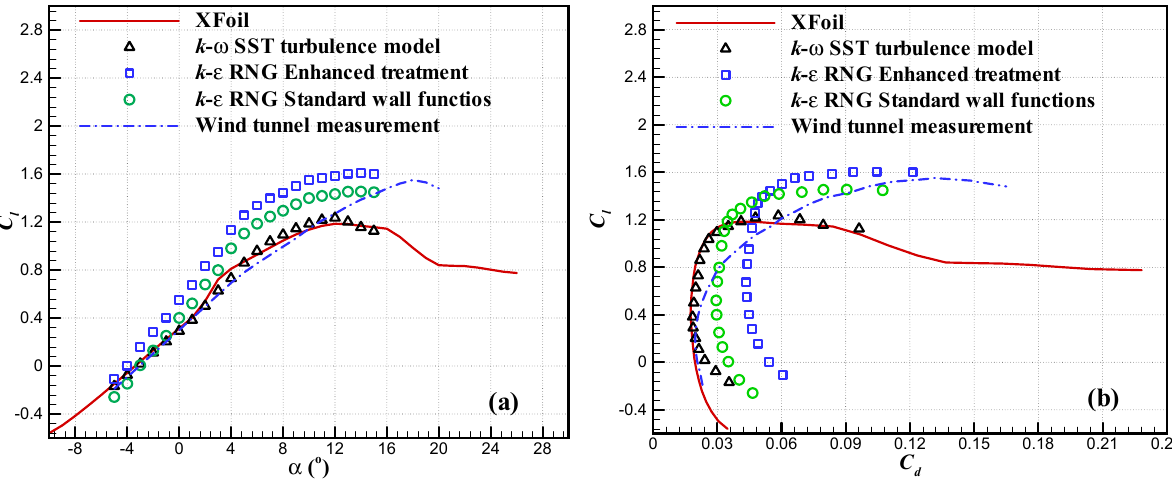
Figure 8. Comparison of lift and drag coefficients between XFoil and Fluent at Re = 1.0 × 10 5 .